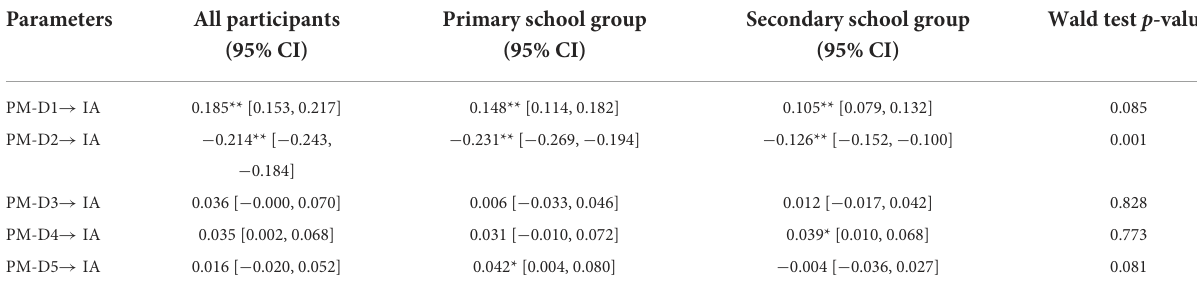
TABLE 2 Estimations of effects of PM on IA.